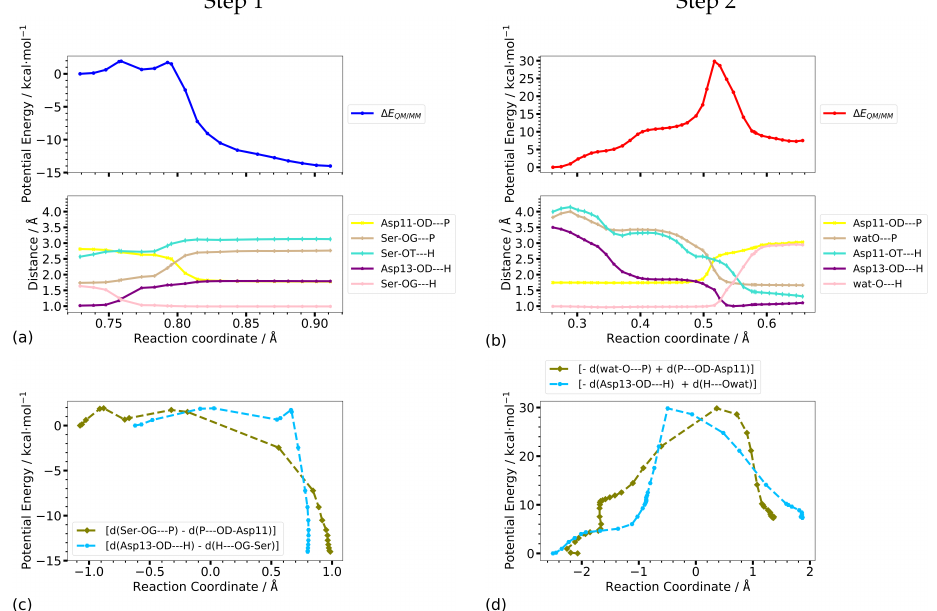
Figure 8. QM/MM minimum energy reaction path profile computed with CPR (top) and important distances (bottom) along the canonical reaction coordinate for the phosphate transfer in ( a ) Step 1 and ( b ) Step 2 of the dephosphorylation reaction in phosphoserine phosphatase. ( c , d ) QM/MM energy as function of the combined reaction coordinates for P–O bond breaking and formation and proton transfer in Step 1 and Step 2, respectively. Energies (in kcal · mol − 1 ) are relative to the intermediate state from which the actual phosphate transfer starts (1IM2 in Figure 5 for Step 1 and 2IM1 in Figure 7 for Step 2,